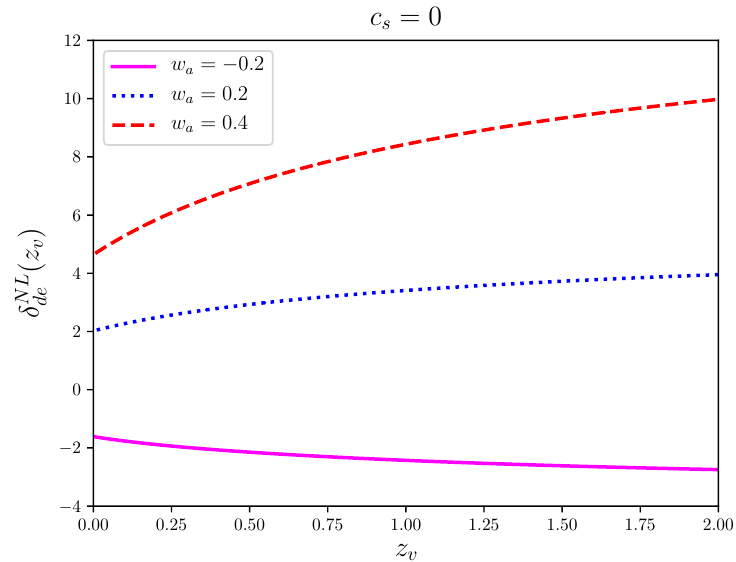
Figure 4. Nonlinear DE fluctuation in the clustering case as a function of the virialization redshift for three values of w a shown in the plot legend; w 0 = for w a = 0.2, we have the pathological values δ NL −